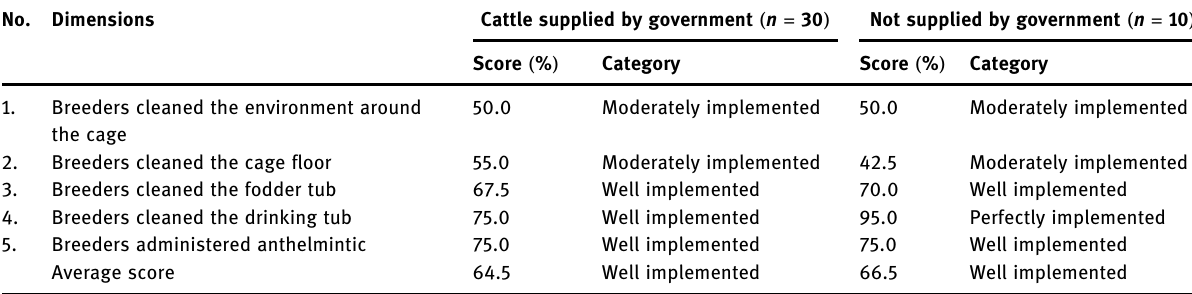
Table 1: Behavior on livestock facilities management of Ongole crossbred cattle farm No. Dimensions